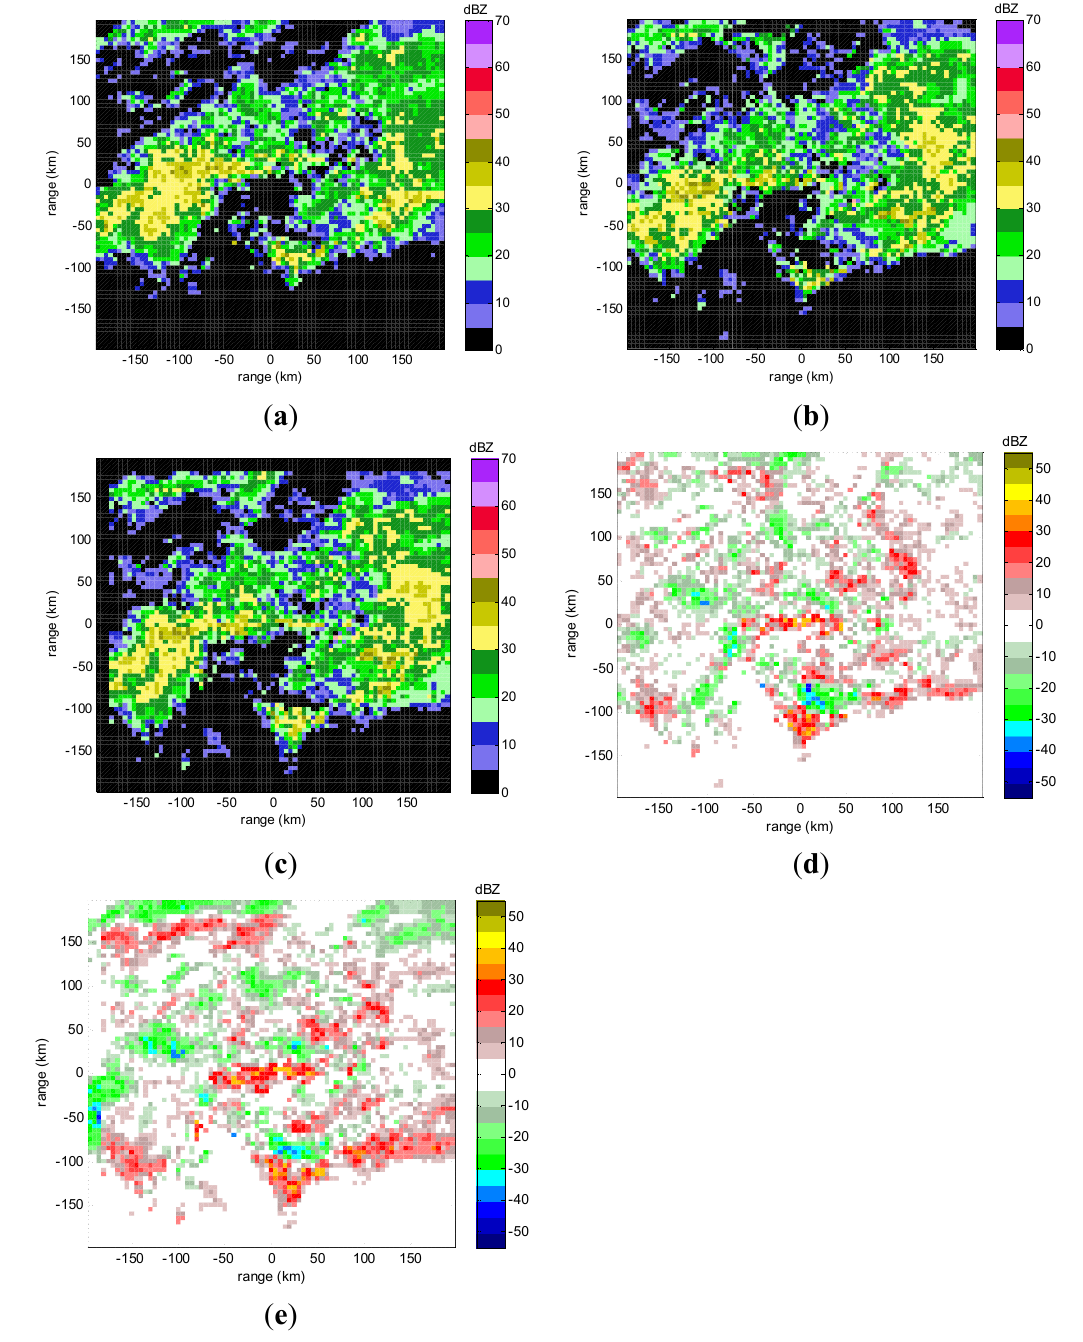
Figure 6. Radar reflectivity at 3 km height of the Nanjing case at 00:30 (UTC) on 12 July 2010 with radar station at origin (0,0). ( a ) actual reflectivity; ( b ) forecasting reflectivity by COTREC; ( c ) forecasting reflectivity by GVAD; ( d ) difference between forecasting reflectivity by COTREC and actual reflectivity; ( e ) difference between forecasting reflectivity by GVAD and actual